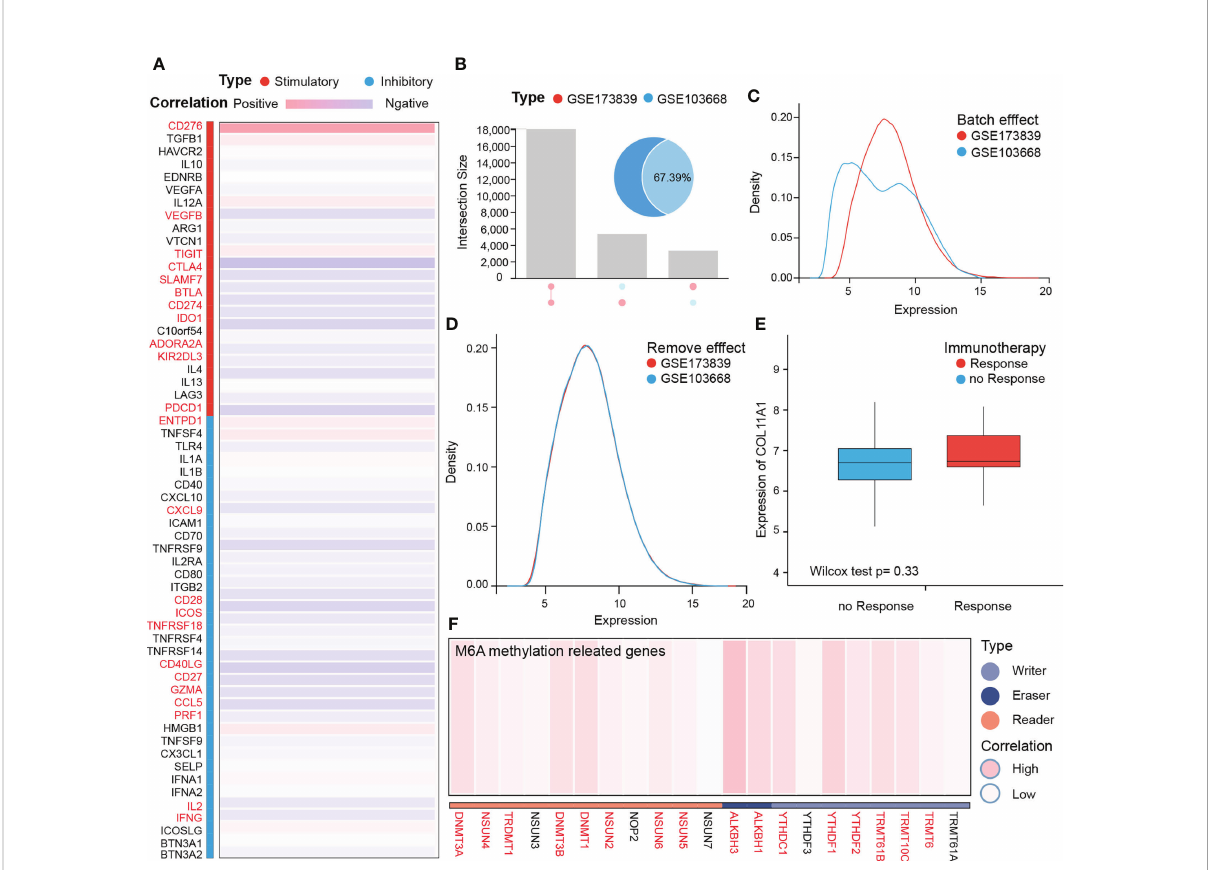
FIGURE 6 COL11A1 predicts the response rate to immunotherapy. COL11A1 is positively correlated with immune checkpoints (CD276, TIGIT, and ENTPD1; p<0.001) (A) Before analysis of two immune therapy datasets have 67.39% genes are overlap, and also have the batch effect, after removing effect, new data with no batch effect (B – D) . COL11A1 expression high in the response group, although not signi fi cant, when compared with no response samples(p=0.33) (E) . In addition, COL11A1 is associated with several m6A methylation-related genes (F)